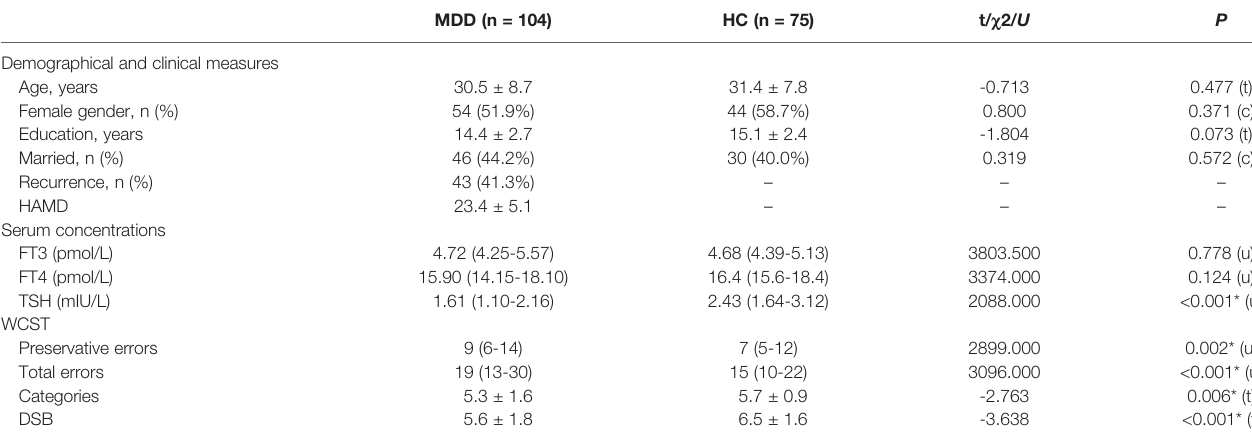
TABLE 1 | Demographic characteristics, clinical parameters, and thyroid function parameters in MDD patients and healthy